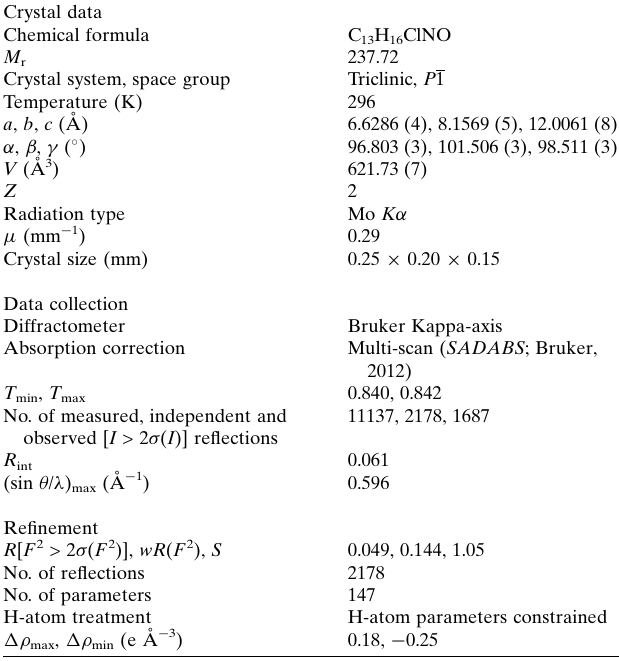
Crystal data Chemical